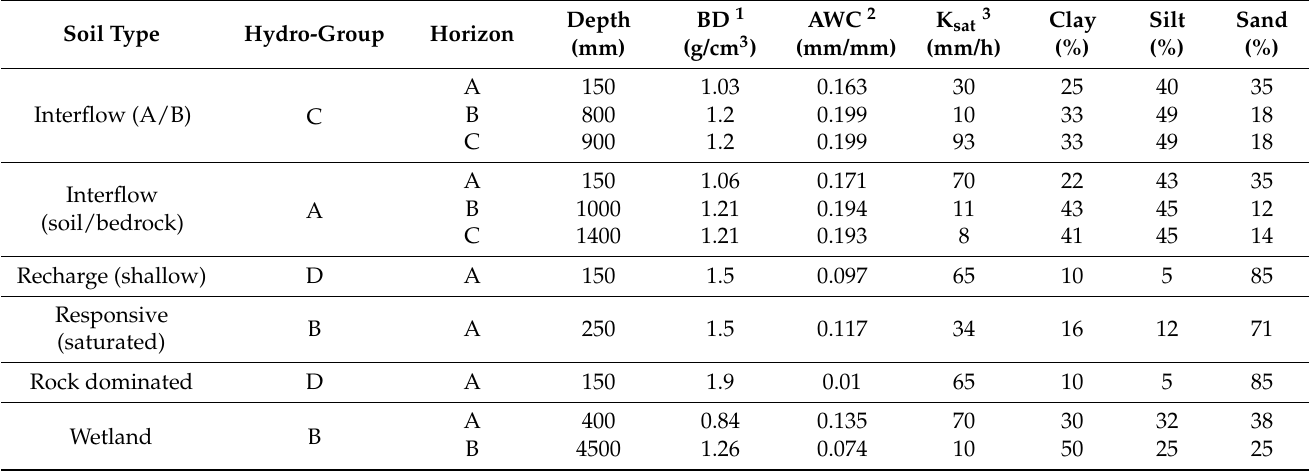
Table 5. Soil types and their respective hydropedological groups and main SWAT+ hydraulic properties of the HSM